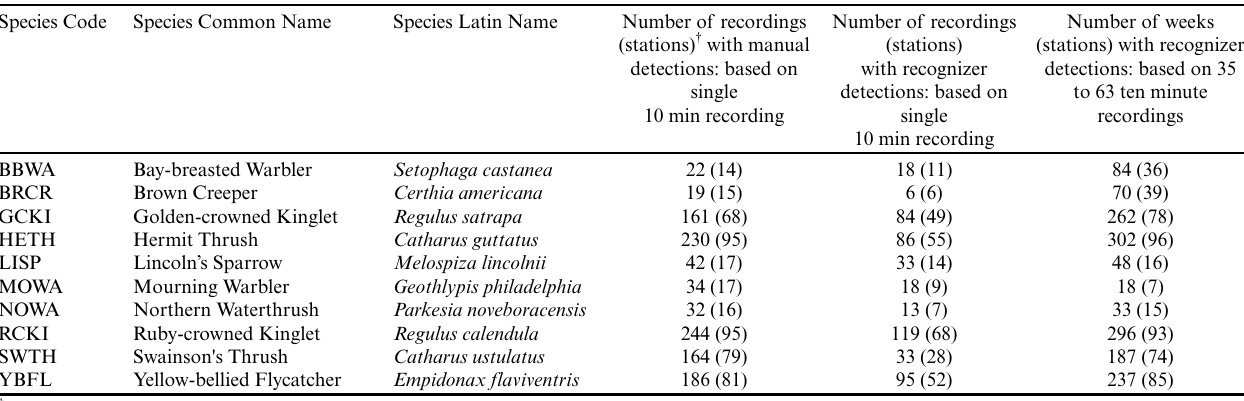
Table 4 . Species list with number of detections in recordings out of 436 and in stations out of 109 for each of (1) manual detection in single 10-minute recordings, (2) song recognition in single 10-minute recordings, and (3) song recognition in each pooled week of 10- minute recordings. Values in parentheses represent the number of occupied stations based on four